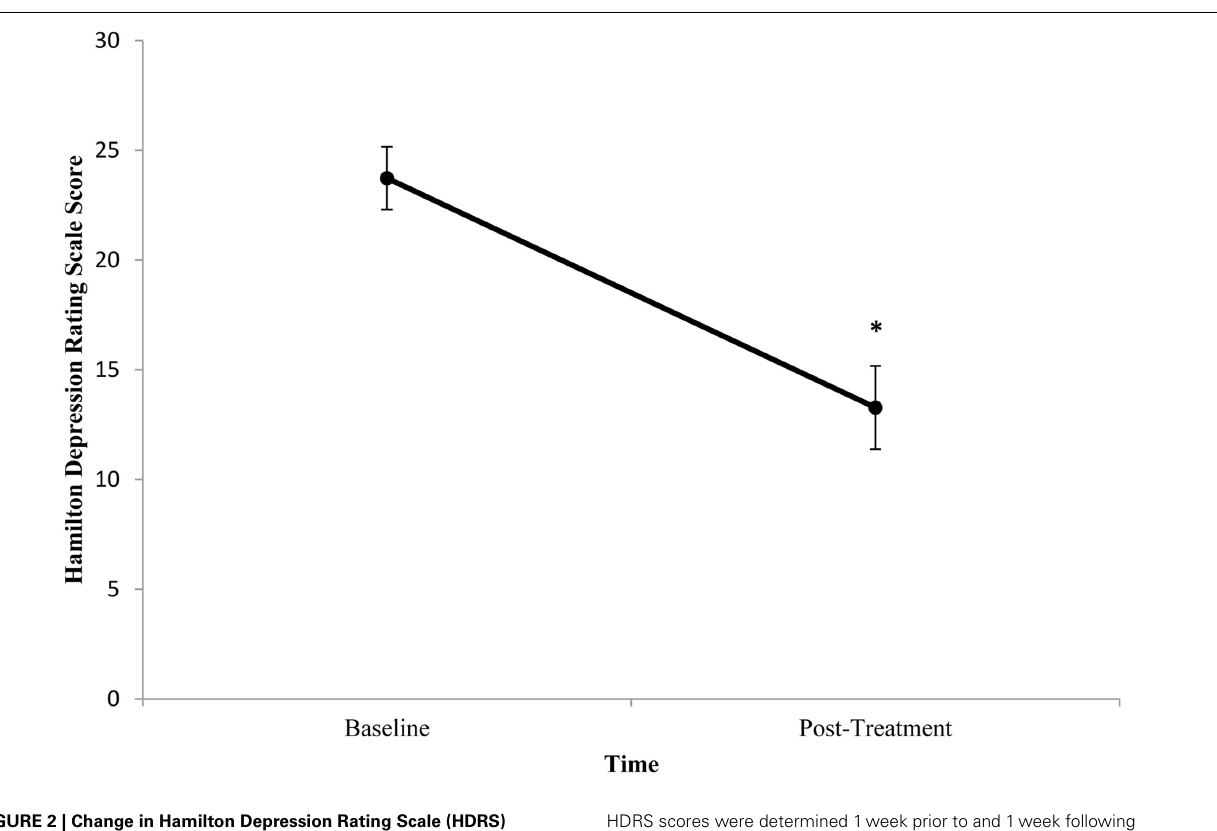
FIGURE 2 | Change in Hamilton Depression Rating Scale (HDRS) score from pre- to post-treatment in patients with major depressive disorder treated with electroconvulsive therapy (ECT).